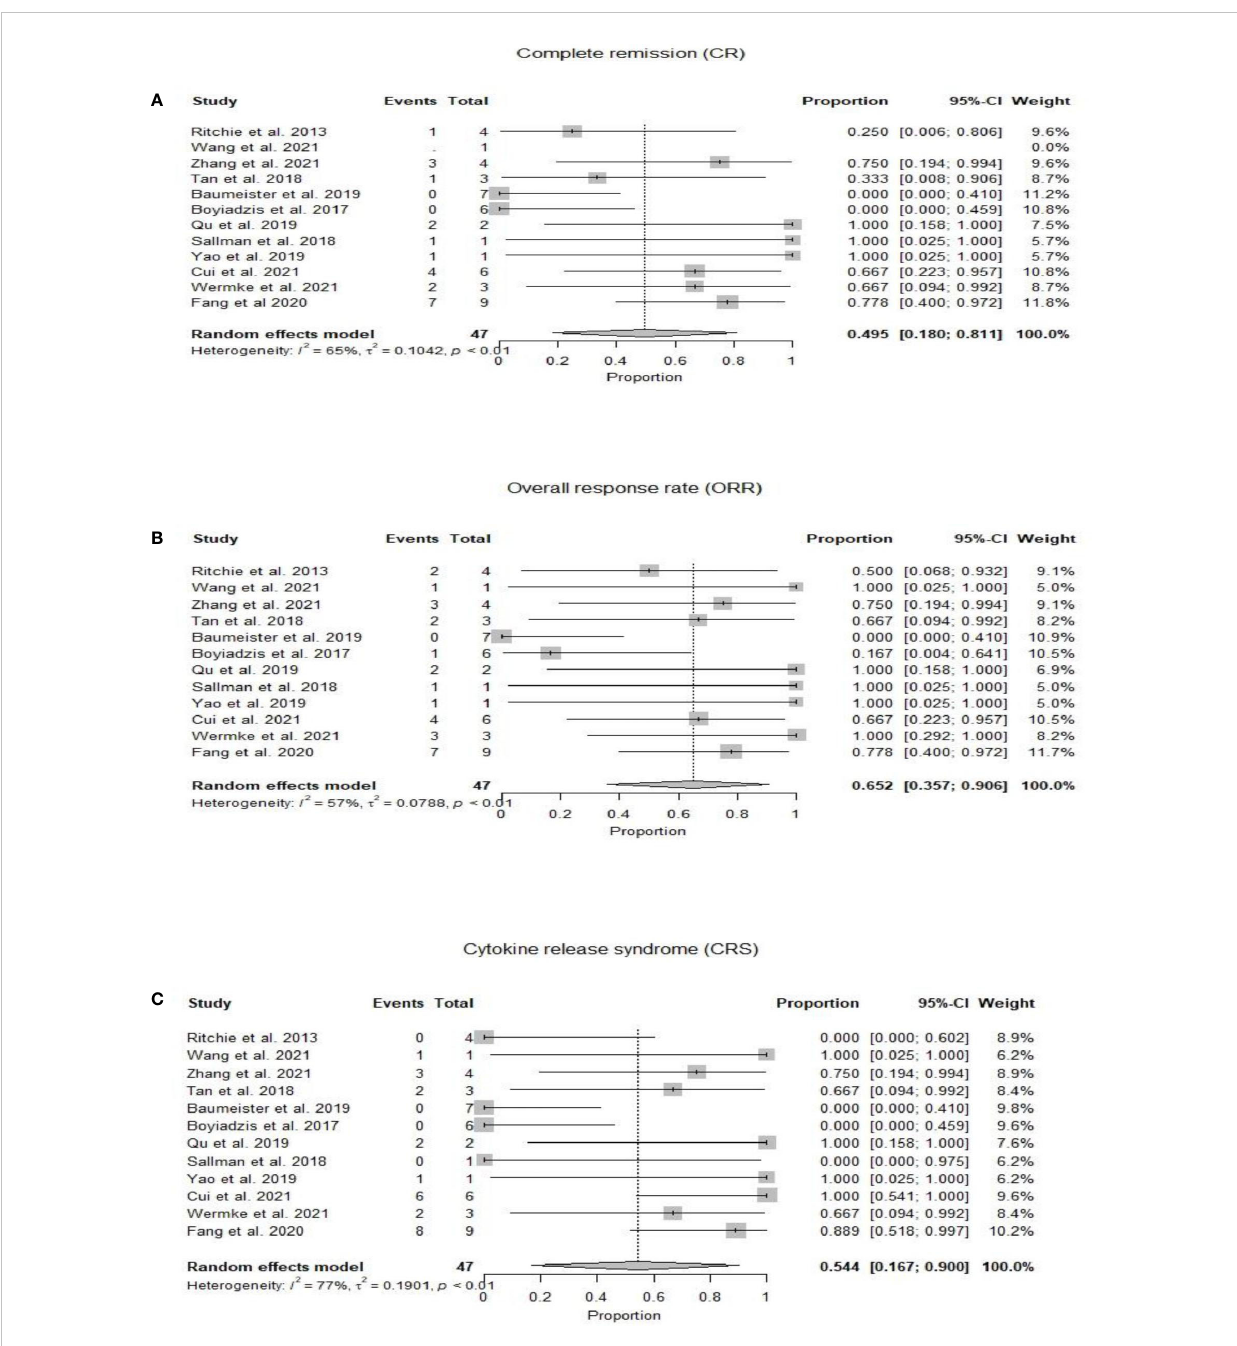
FIGURE 2 (A) Forest plot of complete response rate (CR) post CAR-T therapy for relapsed refractory acute myeloid leukemia. (B) Forest plot of overall response rate (ORR) post CAR-T therapy for relapsed refractory acute myeloid leukemia. (C) Forest plot of cytokine release syndrome (CRS) post CAR-T therapy for relapsed refractory acute myeloid